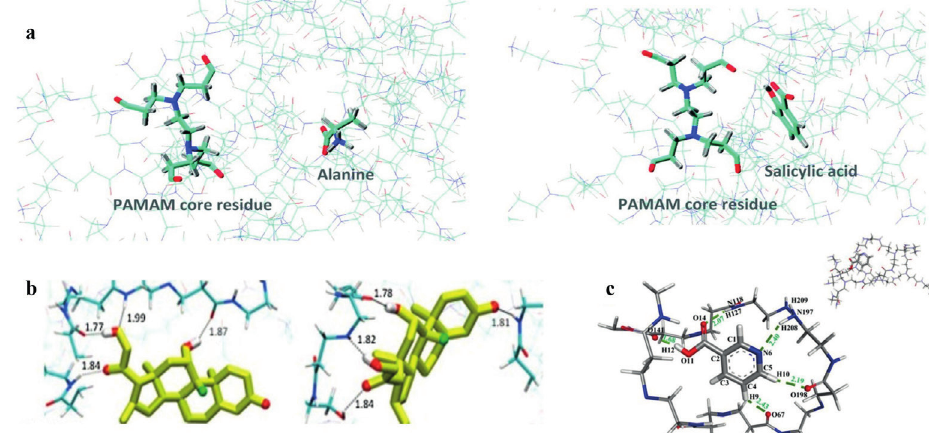
Figure 2 - Proposed model for a complexation between a drug and dendrimers by hydrogen bonds, steric hindrance, electrostatic interactions and Van der Waals interactions. a ) PAMAM dendrimer - Alanine complex and PAMAM dendrimer – Salicylic complex (Maingi 2012), b ) Interaction affinity of the PAMAM-PCL/dexamethasone system by hydrogen bonds (Avila-Salas 2017), c ) Representation of hydrogen bonding interactions between Nicotinic Acid and PAMAM G1 (Badalkhani-Khamseh